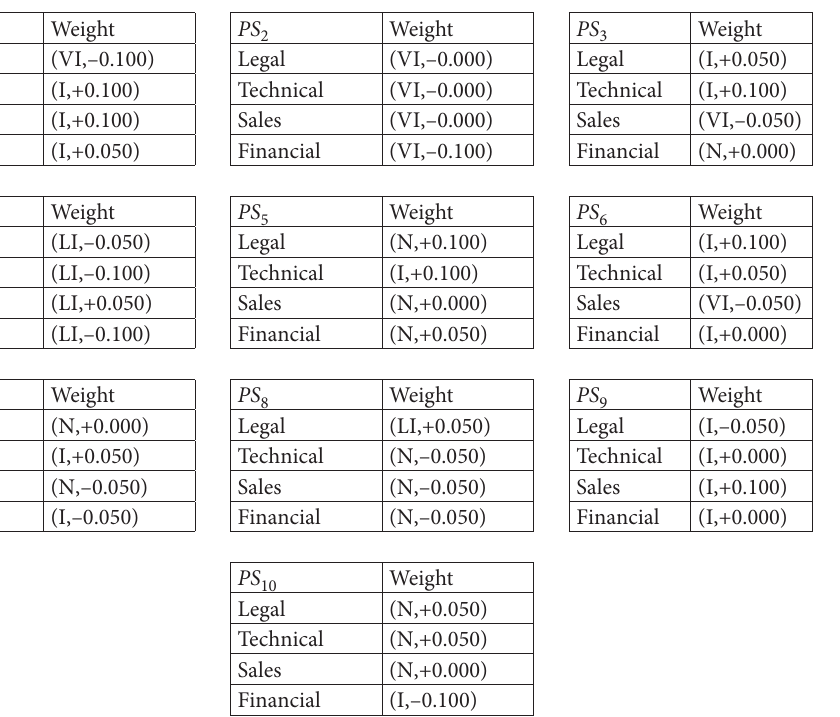
Table 3. Resulting weights per area for each product/service